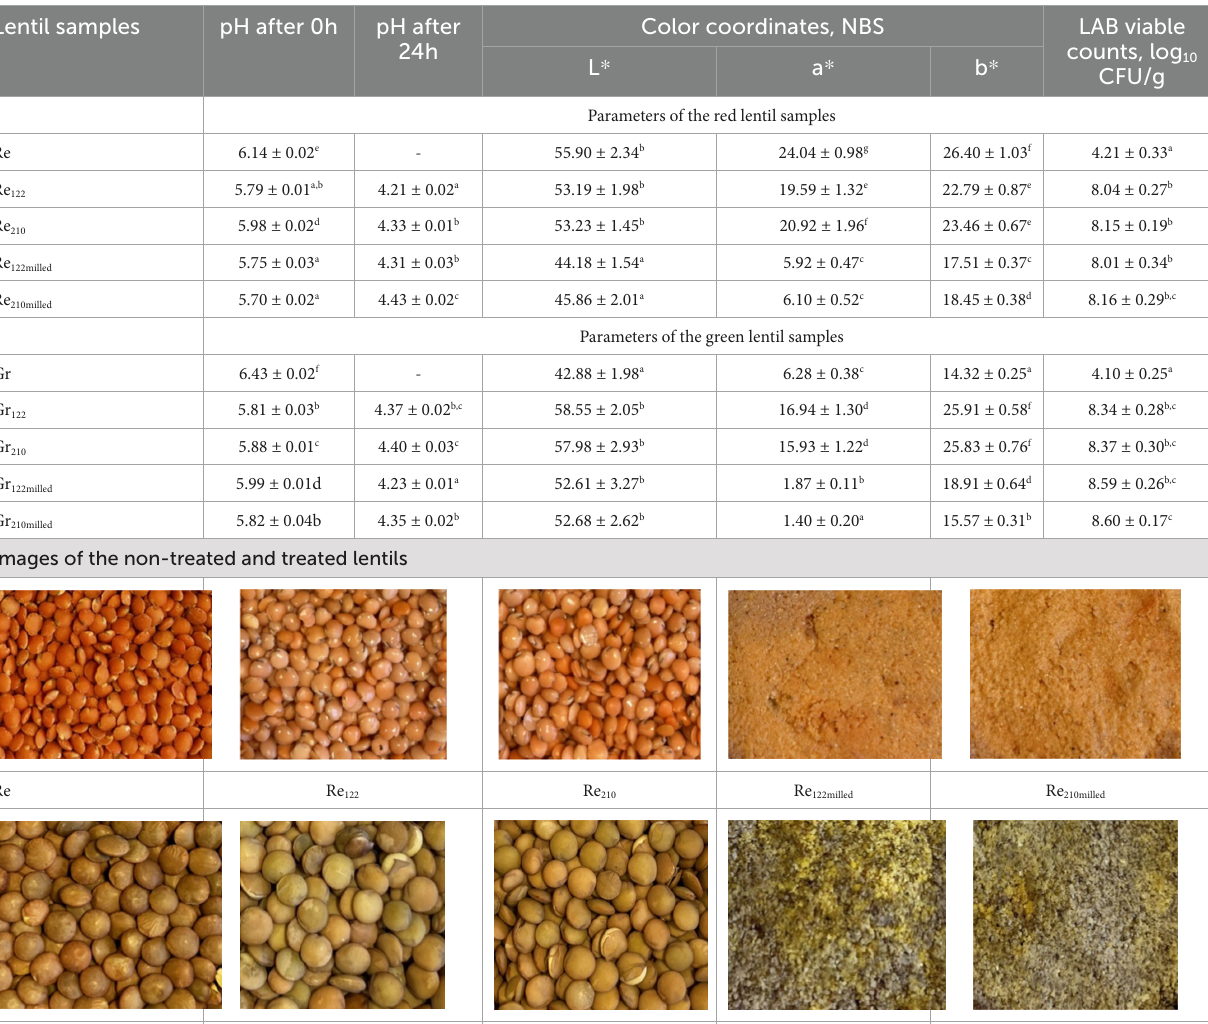
TABLE 1 pH, color coordinates, lactic acid bacteria (LAB) viable counts and images of non-treated and fermented lentils. Lentil